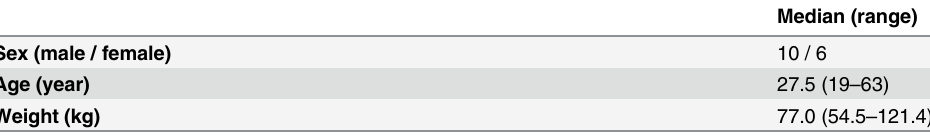
Table 2. Demographics of included subjects (healthy